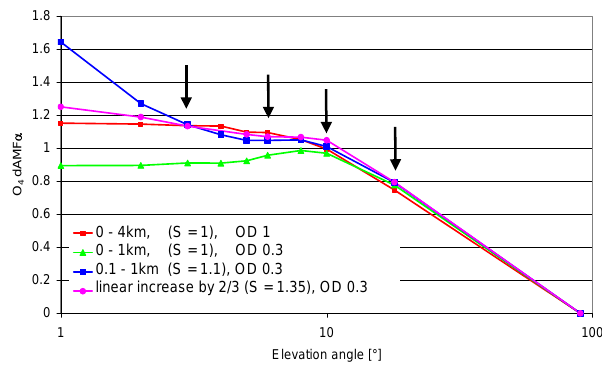
Fig. 6 Simulated O 4 dAMF α for different assumed profile shapes. Besides the elevation angles used in this study (indicated by the black arrows) the calculations also include further elevation angles, especially below 3°. Calculations are preformed for SZA of 30° and a relative azimuth angle of 0°.